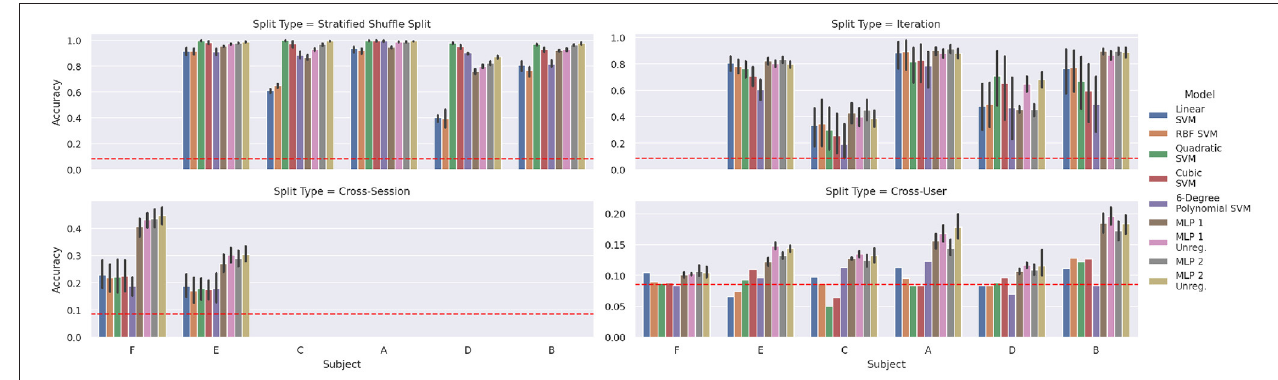
FIGURE 5 | Baseline classification accuracies for verification of results from previous research using the indicated strategies for train/test splits. The dashed red line indicates the random accuracy considering a uniform distribution of samples across the 12 classes, while the vertical lines depict the respective 95% confidence intervals. To improve the statistical relevance of neural network results, each train/test setup was evaluated on five random